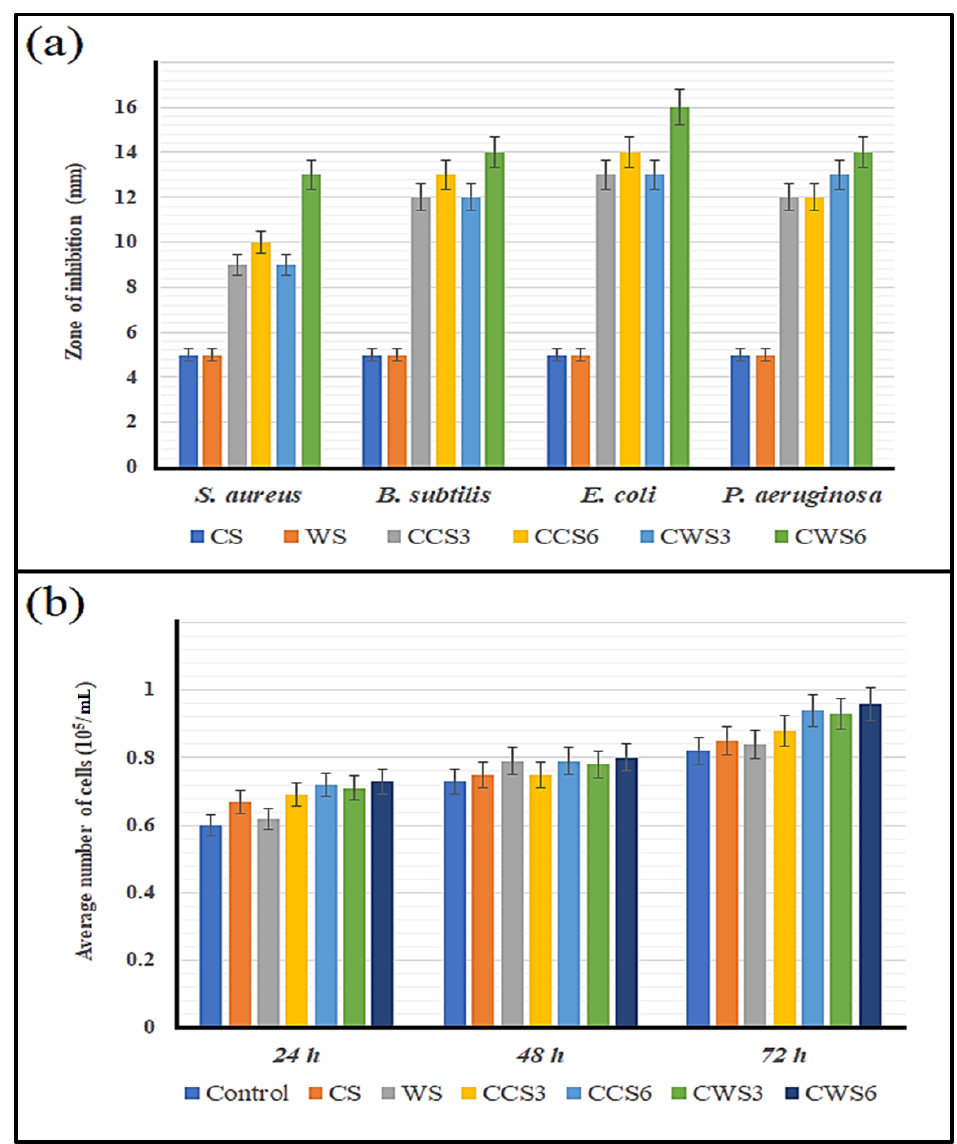
Figure 7. The results of antibacterial activity ( a ) and murine fibroblast biocompatibility ( b ) of prepared hydrogel samples.